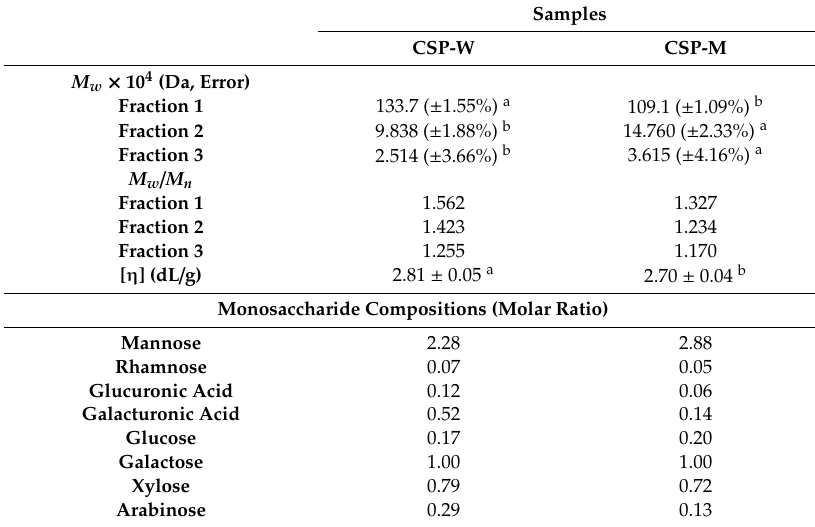
Table 4. Molecular weights ( M w ), polydispersities ( M w / M n ), intrinsic viscosities ([η]), and constituent monosaccharides of CSP-W and CSP-M.